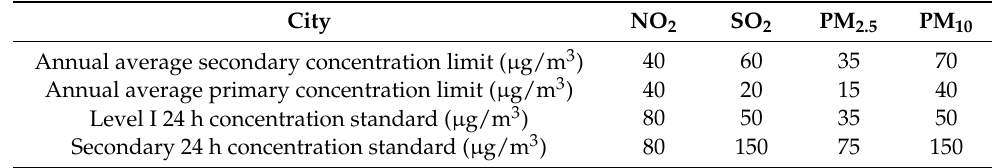
Table 1. The concentration limit in China’s “Ambient Air Quality Standards” (GB3905-2012). City NO 2 SO 2 PM 2.5 PM 10 Annual average secondary concentration limit ( µ g/m 3 ) 40 60 35 70 Annual average primary concentration limit ( µ g/m 3 ) 40 20 15 40 Level I 24 h concentration standard ( µ g/m 3 ) 80 50 35 50 Secondary 24 h concentration standard ( µ g/m 3 ) 80 150 75